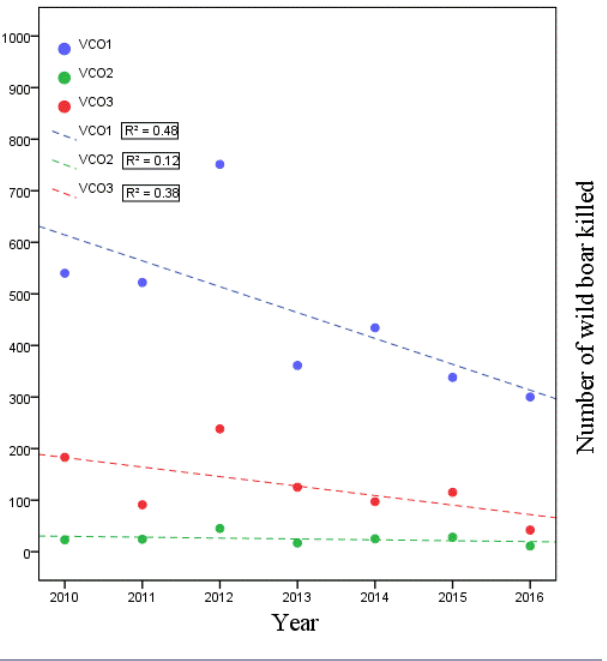
Fig. 4. Trend in the number of wild boar bagged over time from hunting activity in VCO1 and VCO3 hunting areas and from incidental take in VCO2 hunting area from 2010 to 2016. There is a clear decreasing trend in VCO1 and VCO3, and virtually no take in VCO2.